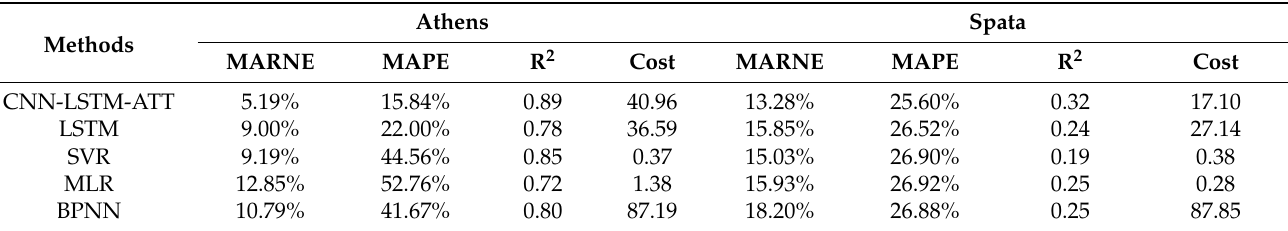
Figure 7. The forecasting curves and errors between CNN-LSTM-ATT and other forecasting models. Table 4. Forecasting results of different